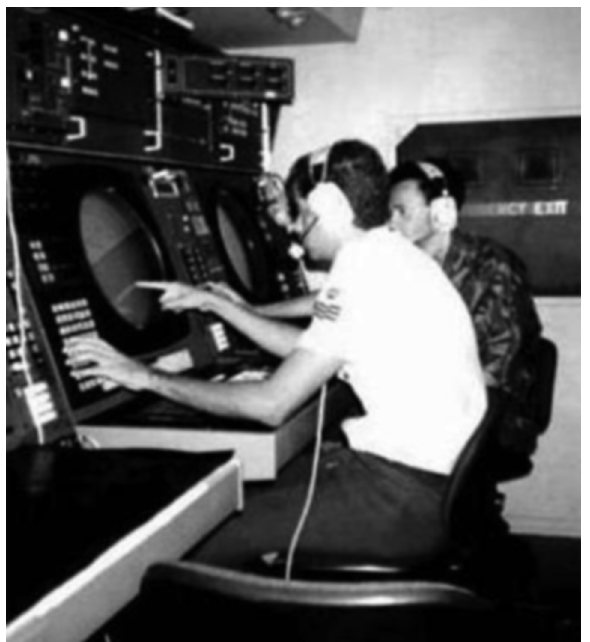
Figure1. Approach Control (APP), Natal, Rio Grande do Norte, Brazil. Natal APP belongs to the third integrated center of air defense and air traffic control (CINDACTA III) of the Aeronautical Command